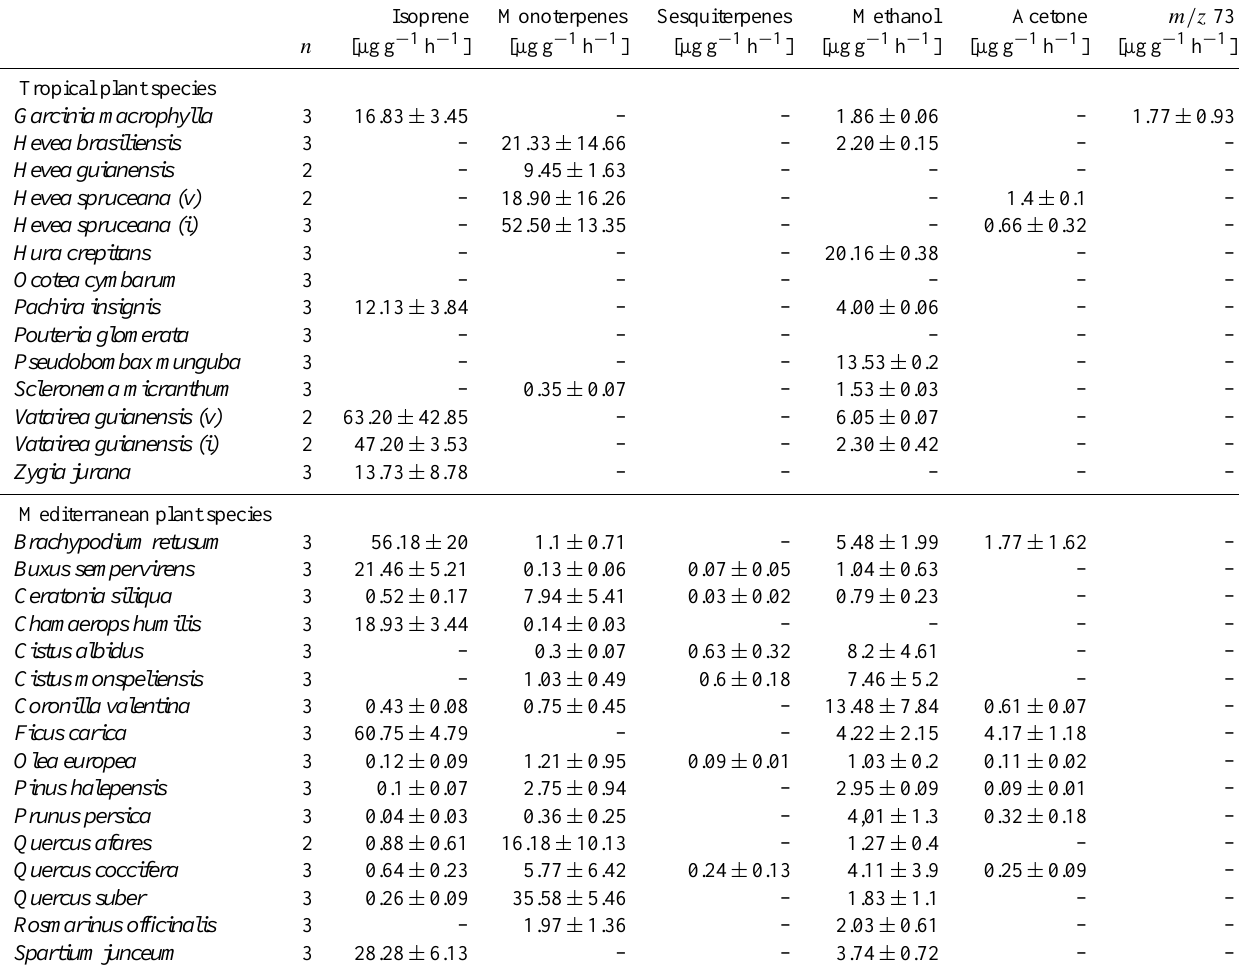
Table 4. VOC emitted a from Mediterranean and tropical plant species measured with PTR-MS (Except for sesquiterpene emissions from Buxus sempervirens , Ceratonia siliqua and Olea europaea that were only detected with GC-FID). All averages ± standard errors are calculated from < 100 samples (tropical) or 18–83 samples (Mediterranean) from n tree